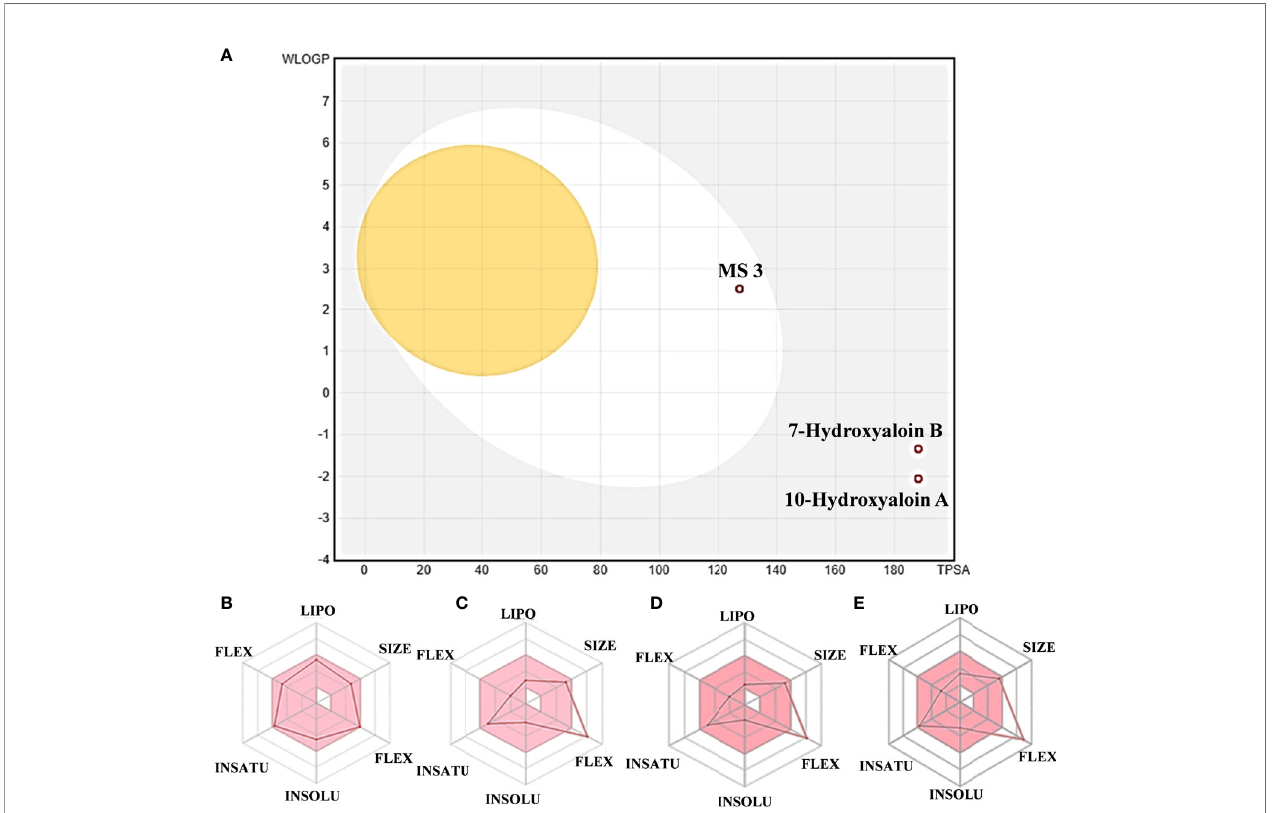
FIGURE 11 | Boiled egg diagram and bioavailability radar map of lead phytochemicals. (A) Boiled egg model of MS 3, 10-Hydroxyaloin A, and 7-Hydroxyaloin B phytochemicals. The isoquercetin molecule value was out of range of the boiled egg plot. Bioavailability radar map of (B) MS 3, (C) 10-Hydroxyaloin A, (D) 7-Hydroxyaloin B, and (E) Isoquercetin. LIPO, lipophilicity; SIZE, molecular weight; POLAR, polarity; INSOLU, insolubility; INSATU, insaturation; FLEX, rotatable bond fl